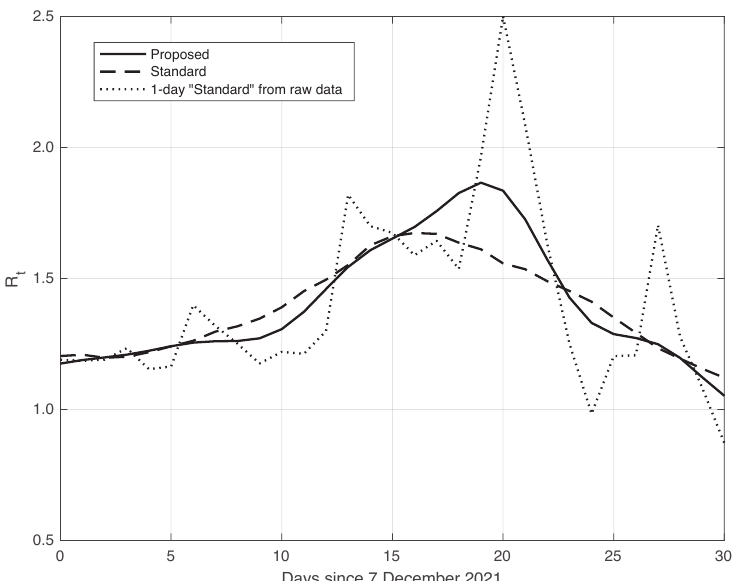
Figure 10. Sequence of the reproduction number R t for real SARS-CoV-2 Italian data from 7 December 2021 to 6 January 2022. The continuous line corresponds to the proposed method, the dashed line to the standard approach, while the dotted line is relative to the estimation by (6) from the raw data.